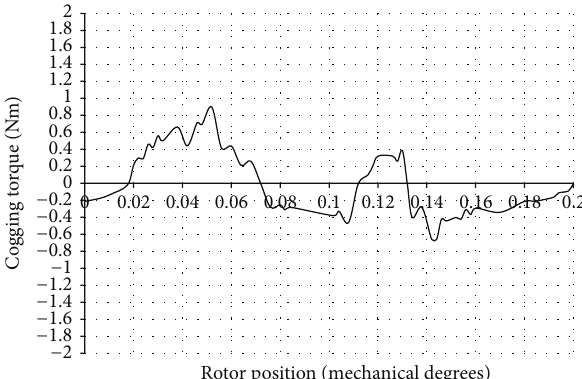
Figure 6: Cogging torque waveform after changing slot opening width.